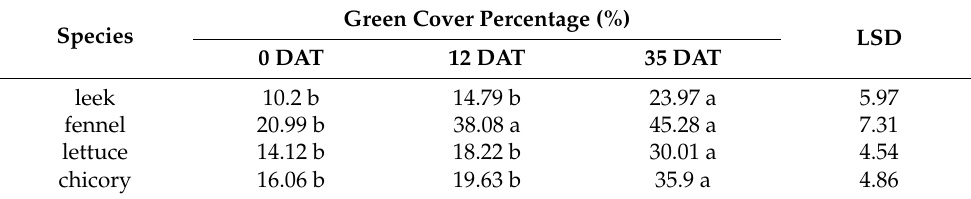
Table 3. Mean values of the green cover percentages of the four different species at different times after transplantation (0 DAT: after transplantation; 12 DAT: 12 days after transplantation; and 35 DAT: 35 days after transplantation). Green Cover Percentage Species